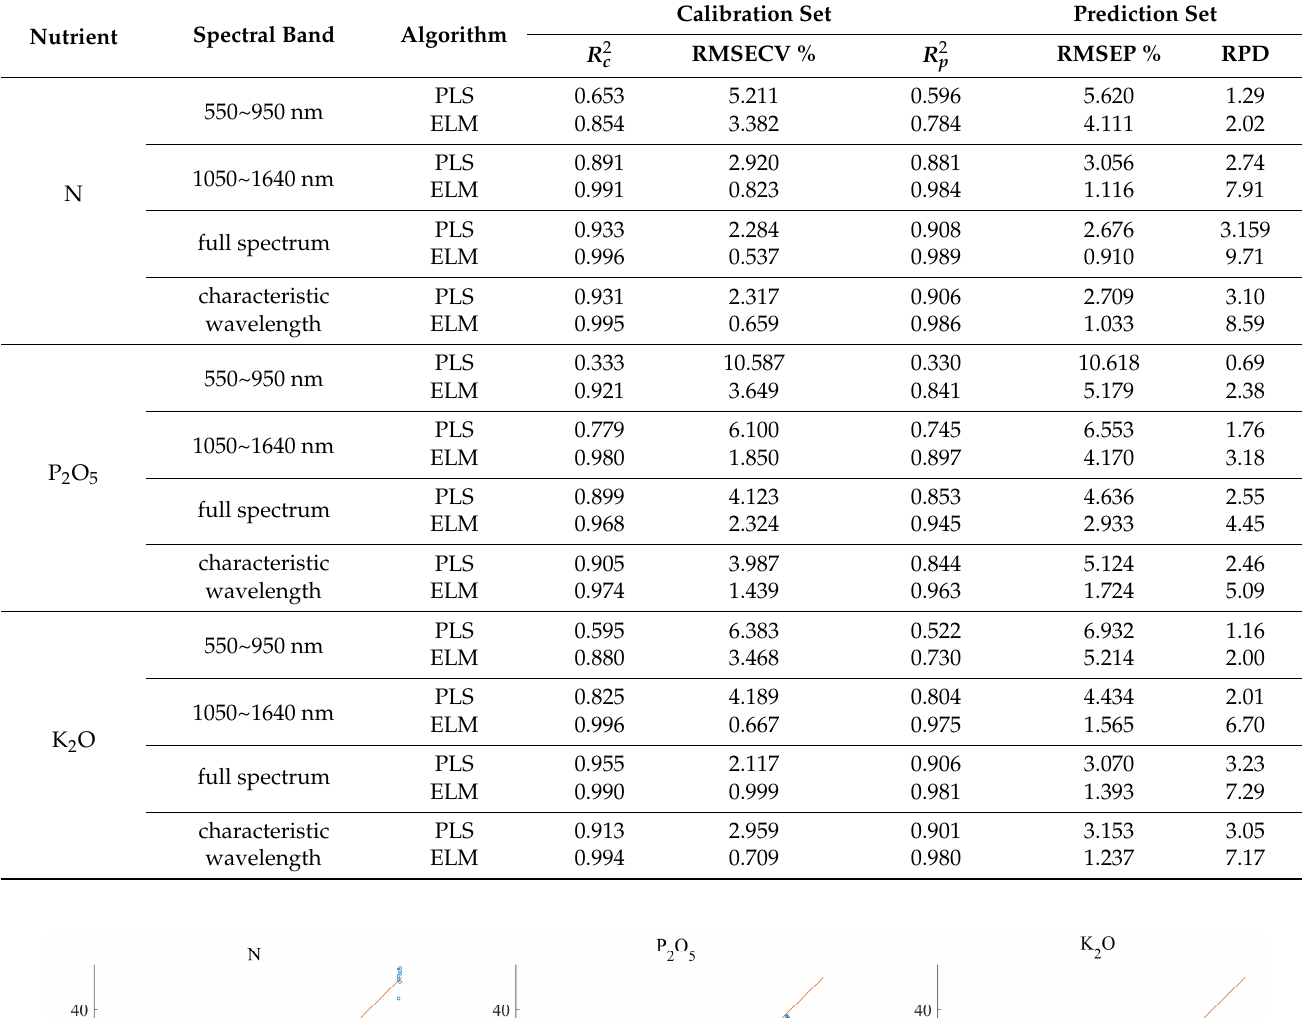
Table 3. The results of N, P 2 O 5 , and K 2 O content models based on different band spectra. Nutrient